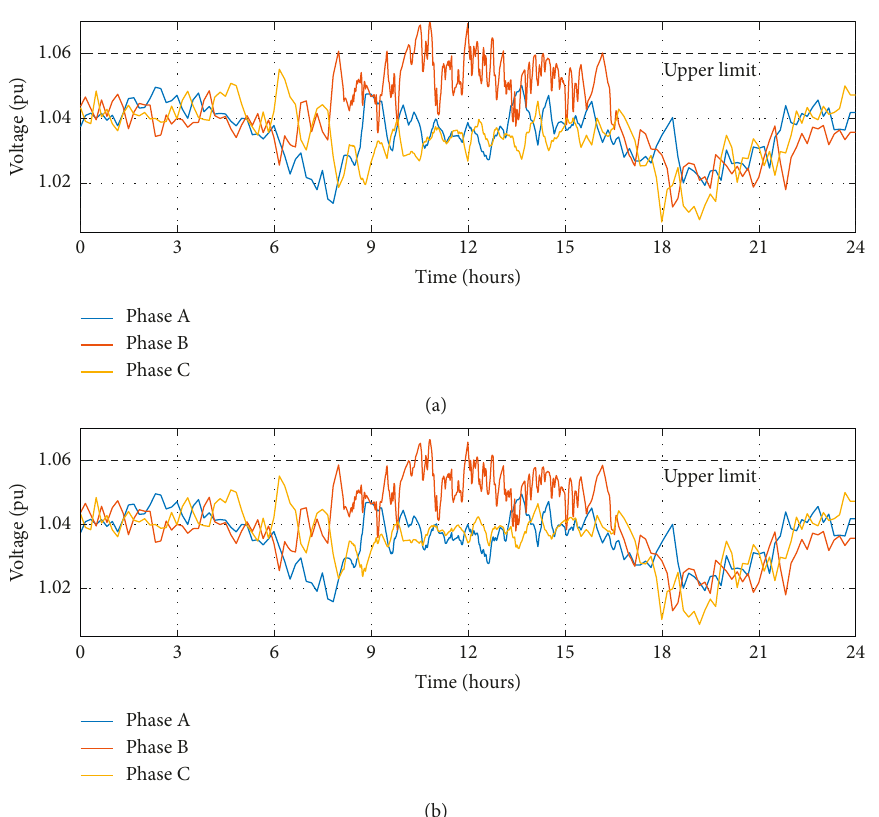
Figure 10: Three-phase voltage profiles with different locally dependent Var compensation methods: (a) constant power factor; (b) power factor droop